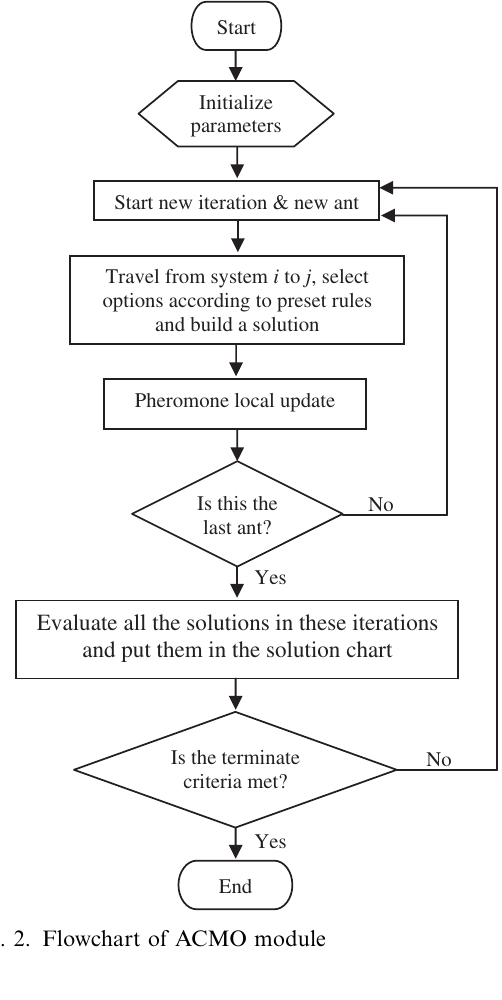
Fig. 2. Flowchart of ACMO module